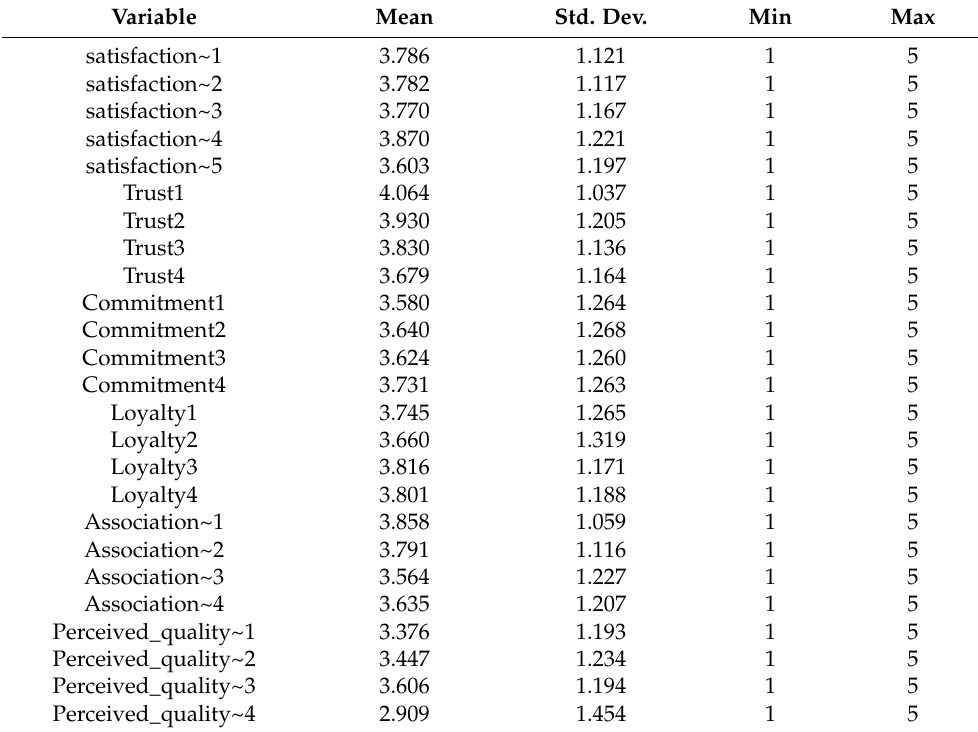
Table A1. Descriptive statistics of